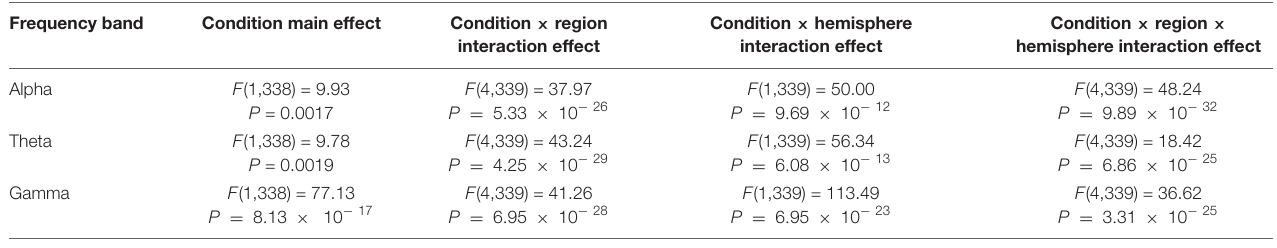
TABLE 2 | The average power variance analysis results of the two hemispheres, five regions, and two conditions in the alpha, theta, and gamma bands for healthy subjects before and after the experiment. Frequency band